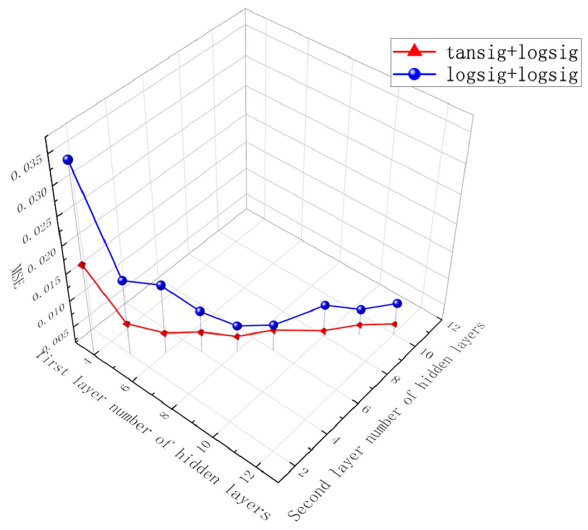
Figure 3. Mean square error ( MSE ) under different node number of hidden layer and activation function combination.